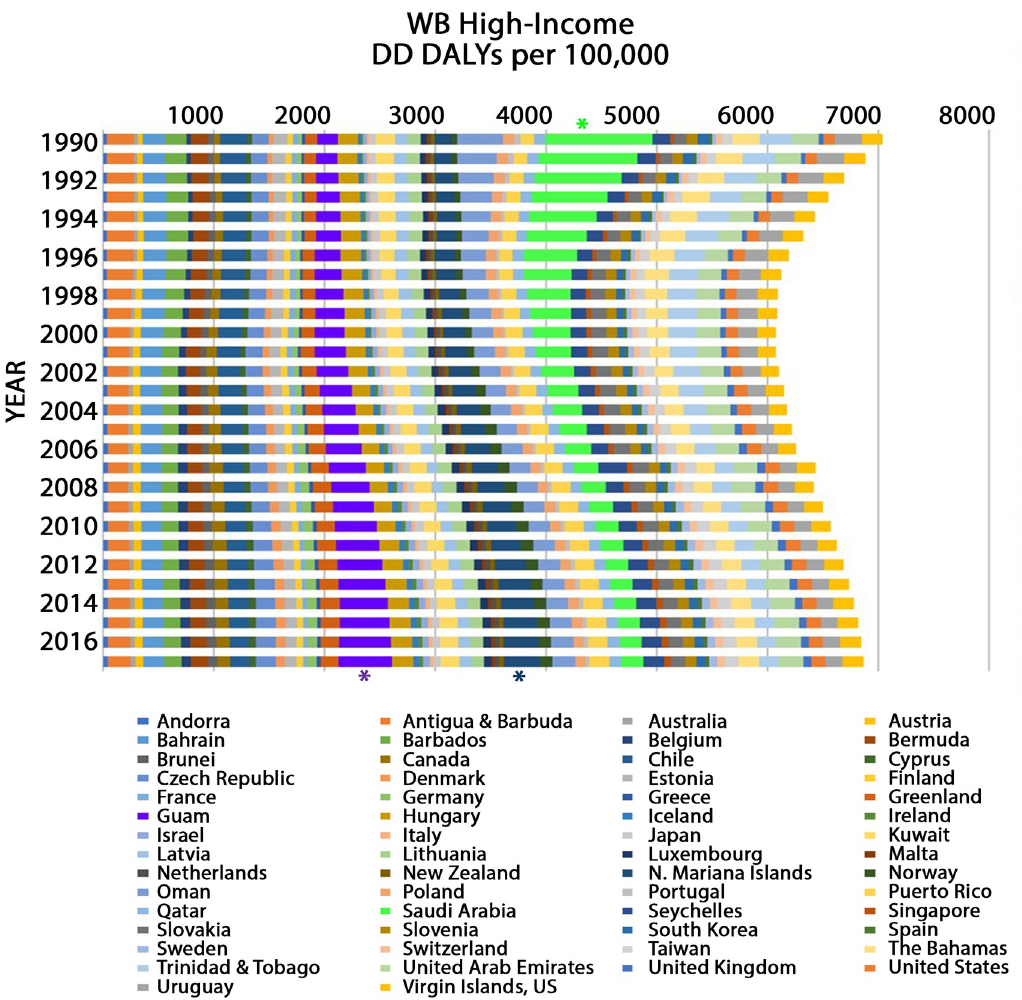
Fig 2. Age-standardized DD DALY rates from 1990 to 2017 in WB high-income constituents. For each year (bar), the total DD DALY rate represents the sum of individual country DD DALY rates given in alphabetical order from left to right as follows: Andorra, Antigua and Barbuda, Australia, Austria, Bahrain, Barbados, Belgium, Bermuda, Brunei, Canada, Chile, Cyprus, Czech Republic, Denmark, Estonia, Finland, France, Germany, Greece, Greenland, Guam, Hungary, Iceland, Ireland, Israel, Italy, Japan, Kuwait, Latvia, Lithuania, Luxembourg, Malta, Netherlands, New Zealand, Northern (N.) Mariana Islands, Norway, Oman, Poland, Portugal, Puerto Rico, Qatar, Saudi Arabia, Seychelles, Singapore, Slovakia, Slovenia, South Korea, Spain, Sweden, Switzerland, Taiwan, The Bahamas, Trinidad and Tobago, United Arab Emirates, United Kingdom, United States, Uruguay, and Virgin Islands. Asterisks identify the countries with the highest number of DD DALYs per 100,000 in 1990 (Saudi Arabia; green asterisk) or in 2017 (Guam; purple asterisk; Northern Mariana Islands; blue asterisk). In 1990, in WB high-income regions, Saudi Arabia exhibited the highest DD DALYs per 100,000 with an estimate of 962.35 (95% UI 662.02–1374.01) (green asterisk, Fig 2), and the Netherlands had the lowest DD DALYs per 100,000 with an estimate of 16.52 (95% UI: 12.27– 21.60). In 2017, the US territories of Guam (purple asterisk, Fig 2) and the Northern Mariana Islands (blue asterisk, Fig 2) were among those constituents with the highest DD DALYs per 100,000, with estimates of 483.37 (95% UI: 335.04–663.90) and 326.23 (95% UI: 230.68– 443.61), respectively. In 2017, Malta had the lowest DD DALYs per 100,000 with an estimate of 25.90 (95% UI: 19.58–33.28). Furthermore, there was an interesting temporal trend in WB high-income countries. Unlike the steady annual decline seen in WB low-income countries,